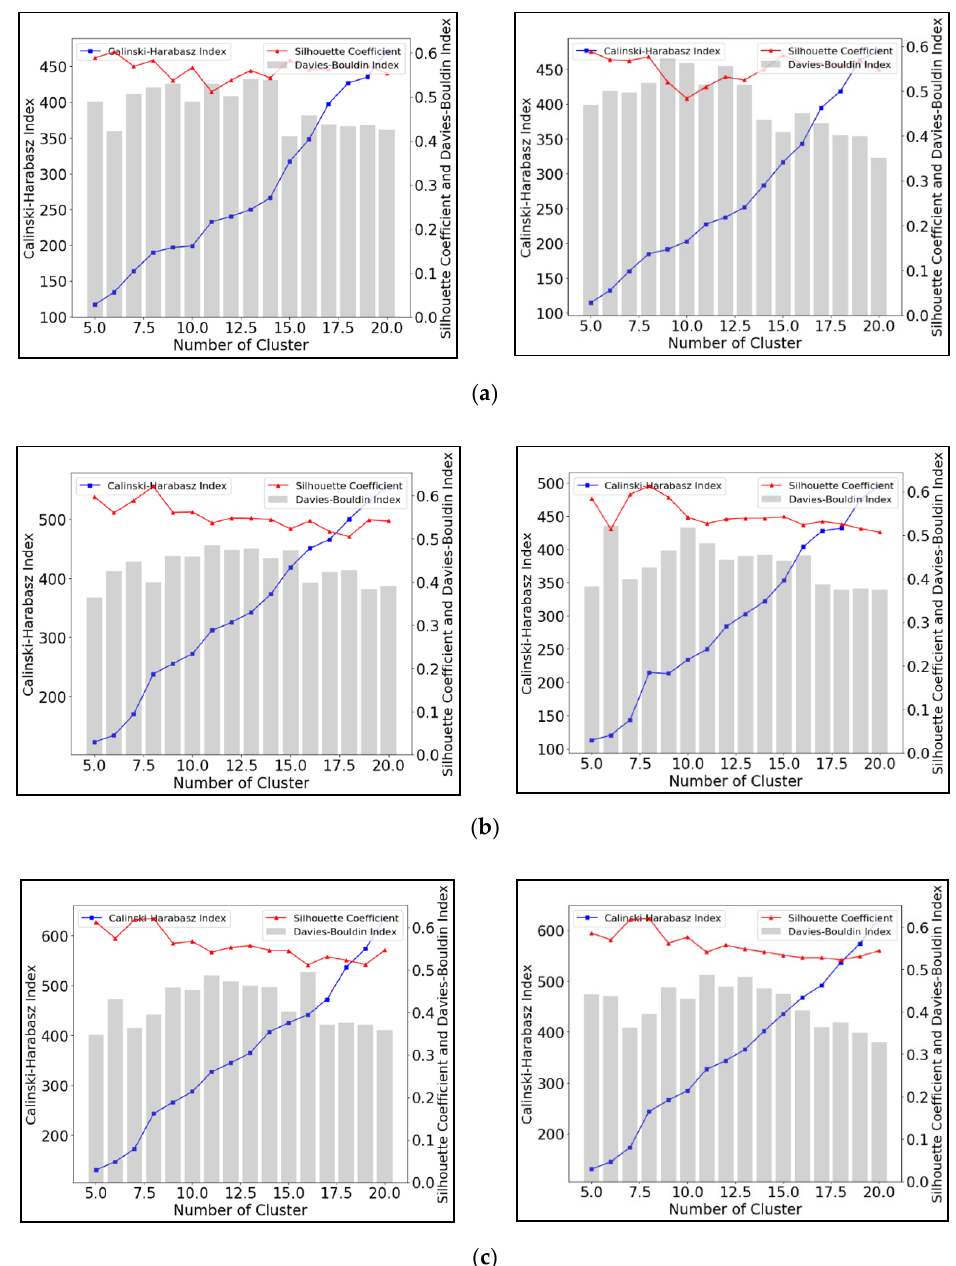
Figure 5. Performance evaluation for K-means Clustering with different cluster numbers under synthetic rainfall scenarios including ( a ) 3-h (left 2-year and right 5-year), ( b ) 12-h (left 2 year and right 5 year), and ( c ) 48-h duration (left 2 year and right 5 year).